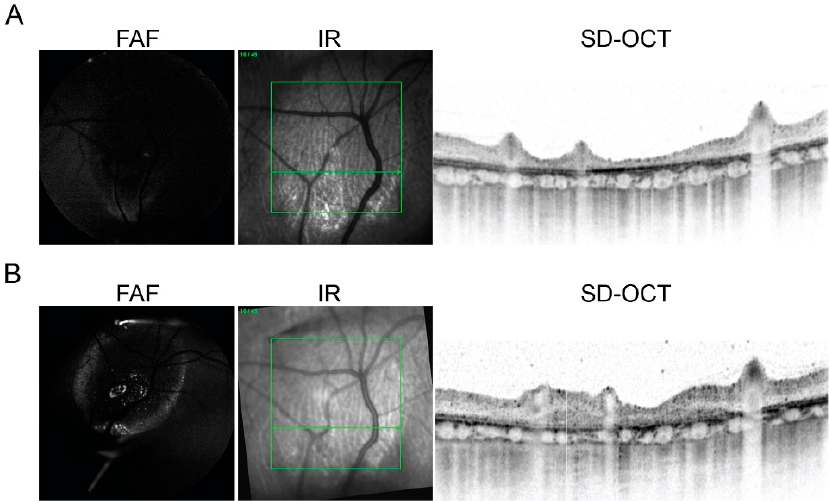
Figure 3. Representative image of FAF and SD-OCT of ( A ) prior to and ( B ) two weeks after hiPSC-RPE cell subretinal injection in pig 6. ( A ) The day before hiPSC-RPE cell injection, no evidence of hyper-autofluorescence due to GFP expression is observed on FAF, and a marked atrophy and thinning of all retinal layers is present on SD-OCT. ( B ) Fifteen days after the hiPSC-RPE cell injection, several foci of hyper-autofluorescence are observed inside the area of atrophy on FAF, but also an increase in retinal thickness as compared with ( A ). Green squares delineate scan area and green horizontal line show scan directions and level of right image FAF, fundus autofluorescence; GFP, green fluorescence protein; SD-OCT, spectral-domain optic coherence tomography; RPE, retinal pigment epithelium.